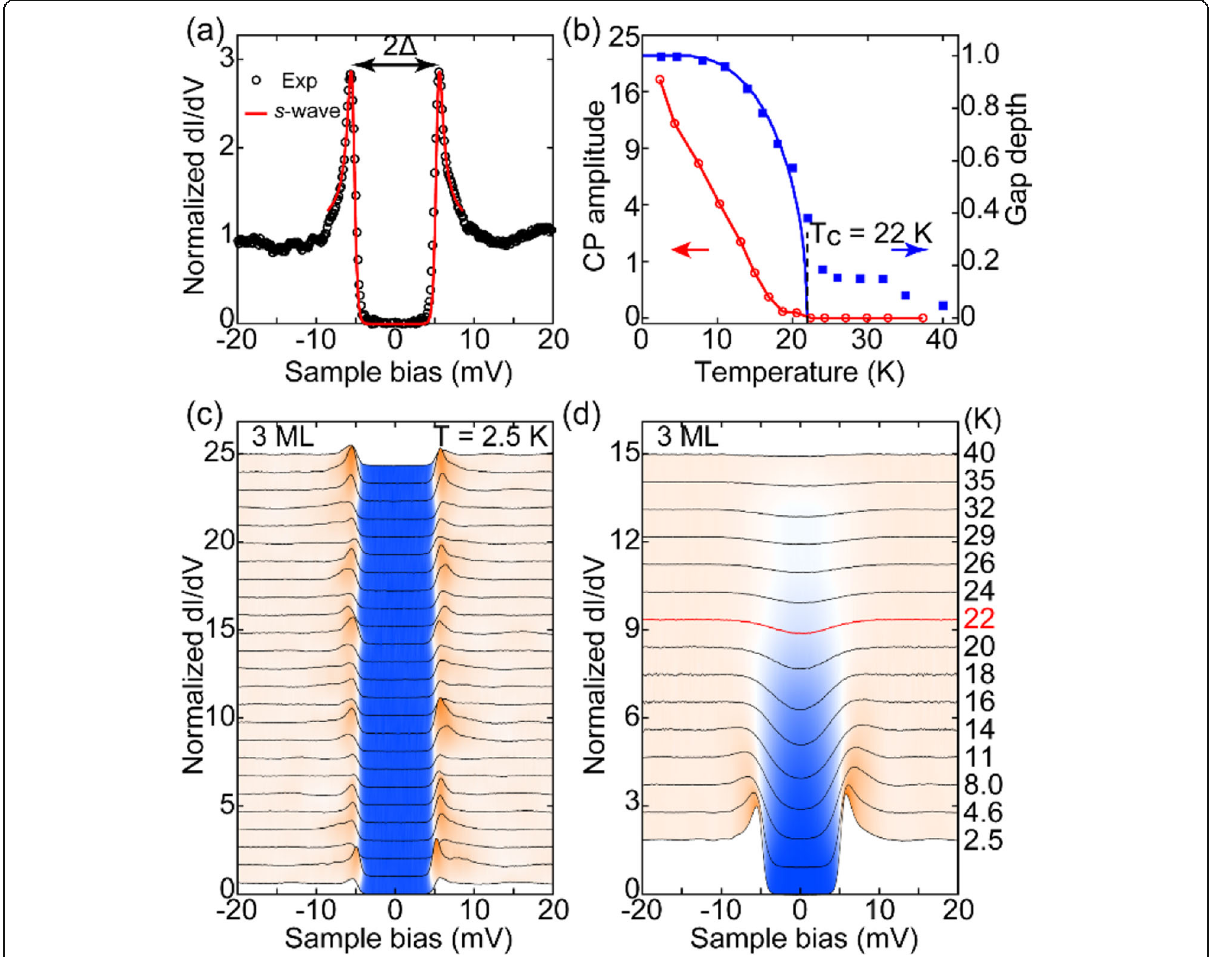
Fig. 9 Superconductivity in 3 ML K 3 C 60 . ( a ) d I /d V spectrum taken at 2.5 K and its best fit to an isotropic s -wave superconducting gap. ( b ) Temperature dependence of the coherence peak (CP) amplitude and gap depth, revealing a T c of 22 K. ( c ) Grid d I /d V spectra taken at 2.5 K in a field of view of 20 nm × 20 nm. ( d ) Spatially averaged d I /d V spectra as a function of temperature. Taken from ref.